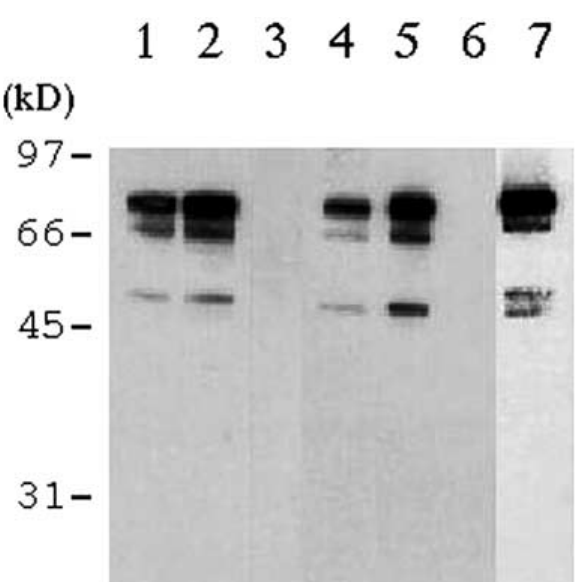
FIGURE 1 Immunization of SJL/J mice with PDC-E2 induces AMA. Sera isolated from SJL/J mice immunized with PDC-E2 as well as PBC patient sera recognized PDC-E2 (74kD) and OGDC (48kD). Lanes 1 and 2 represent sera isolated at 7 weeks from mice immunized with PDC-E2. Lane 3 represents sera isolated at 7 weeks from a mouse immunized with a -casein. Lanes 4 and 5 represent sera isolated at 30 weeks from mice immunized with PDC-E2. Lane 6 represents sera isolated at 30 weeks from mice immunized with a -casein. Lane 7 is serum from a PBC